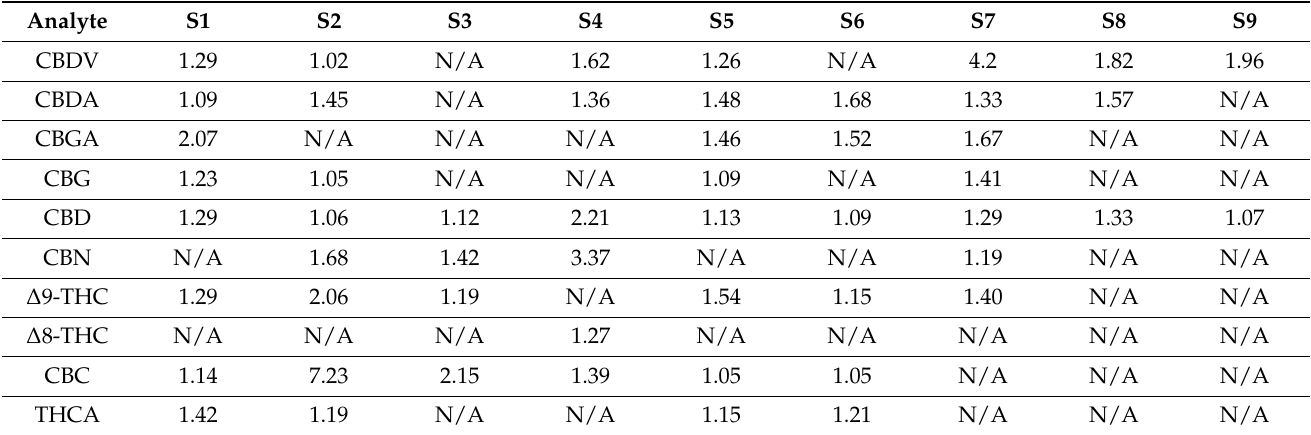
Table 2. Peak purity indexes of each peak from sample solutions (300